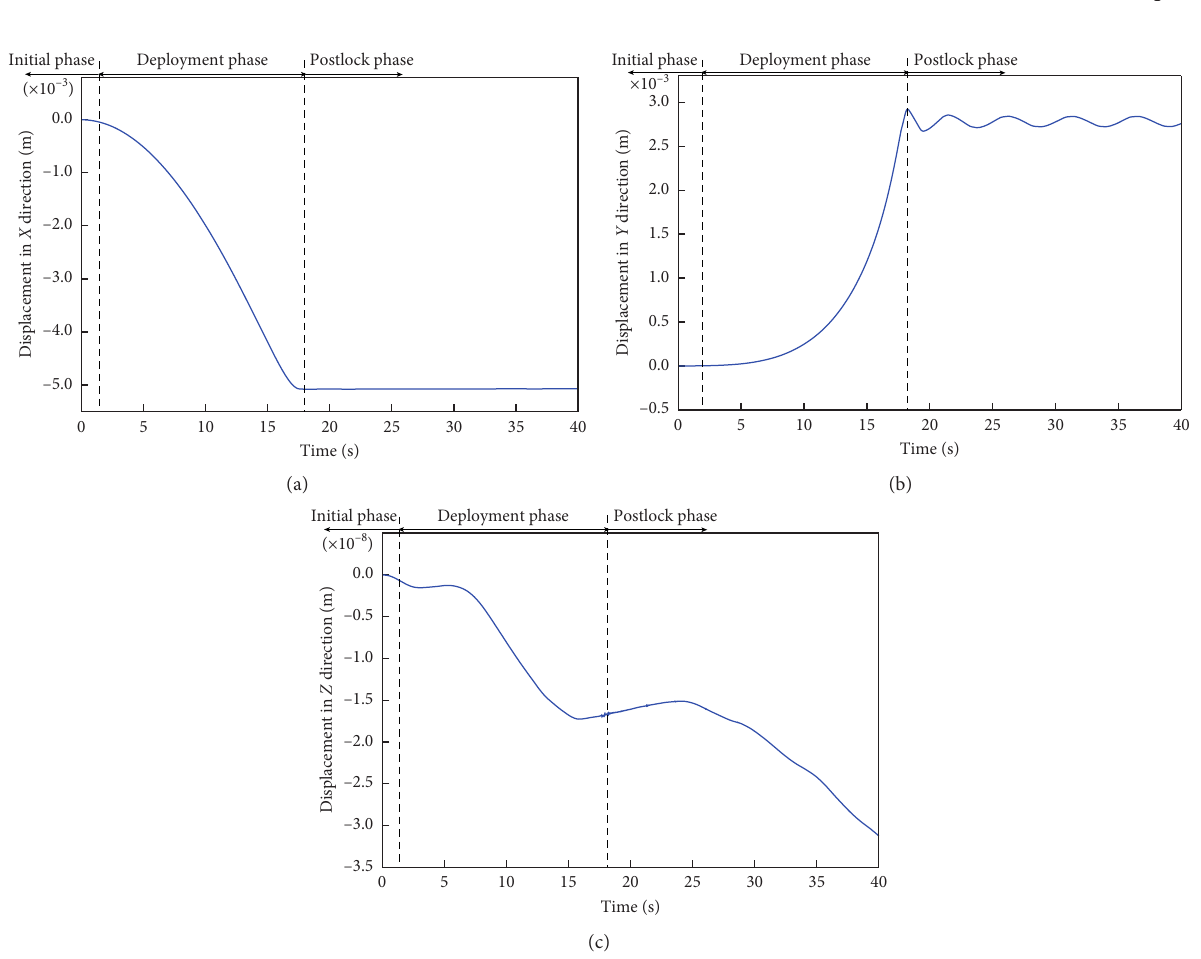
Figure 13: Displacement responses of the spacecraft main body in the three